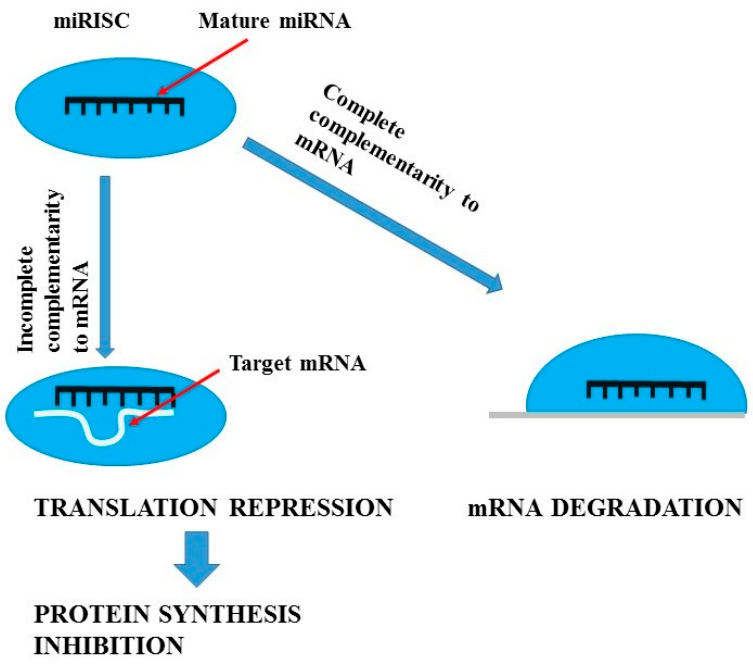
Figure 1. Mechanisms of miRNA action (figure was prepared and modified on the basis of [92]).